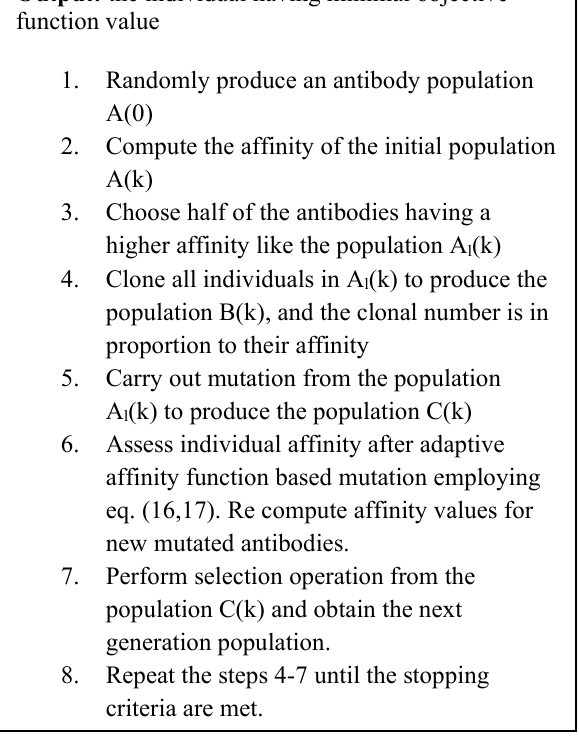
Algorithm 2. Modified clonal Selection algorithm